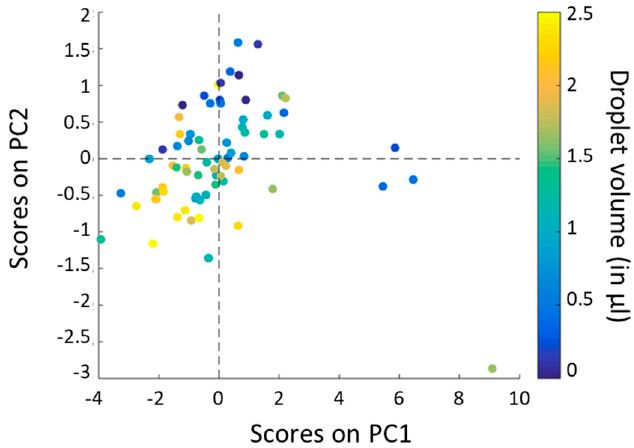
Figure 7. Score plot on PC1 and PC2 generated from the whole dataset.